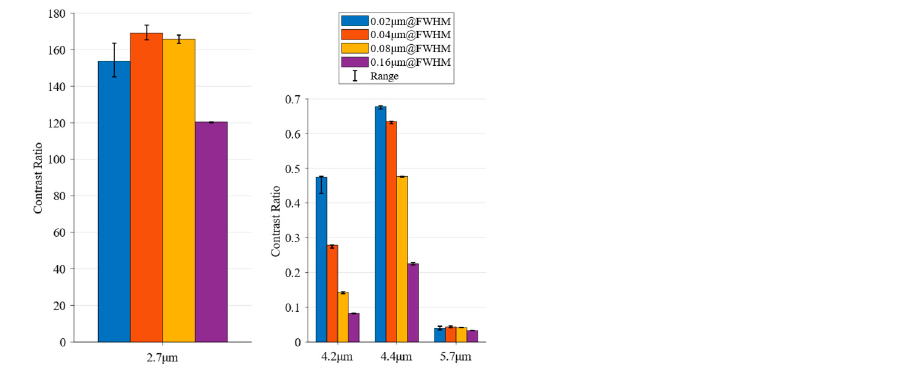
Figure 14. Contrast and its variation range with different center wavelengths and FWHMs.